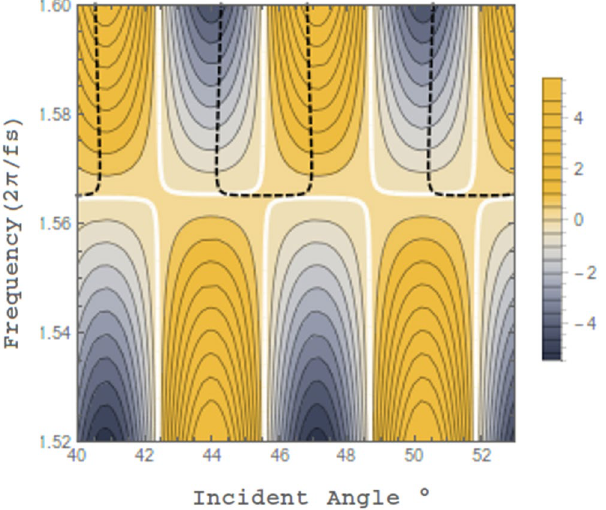
Figure 5. Plotted is the deviation from the PAR condition represented by the equality in eqn. (5). The black (dashed) and white lines denote values for which the frequency and incident angle satisfy the PAR conditions of eqns (4) and (5) respectively. Crossing points of the white and black dashed lines which satisfy the conditions for PAR agree well with the narrow dip in reflectivity of Fig. 2 between 1.55–1.57